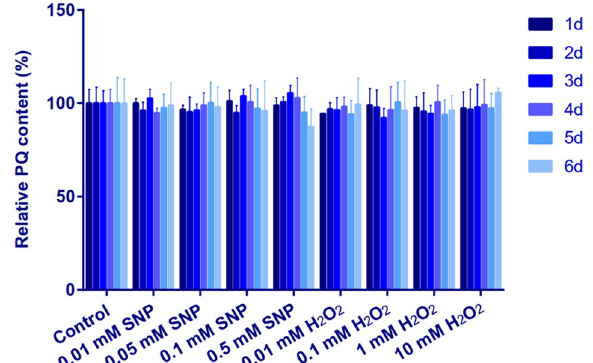
Figure 8. Perylenequinones content on different treatments. Values are the means of five independent experiments ±